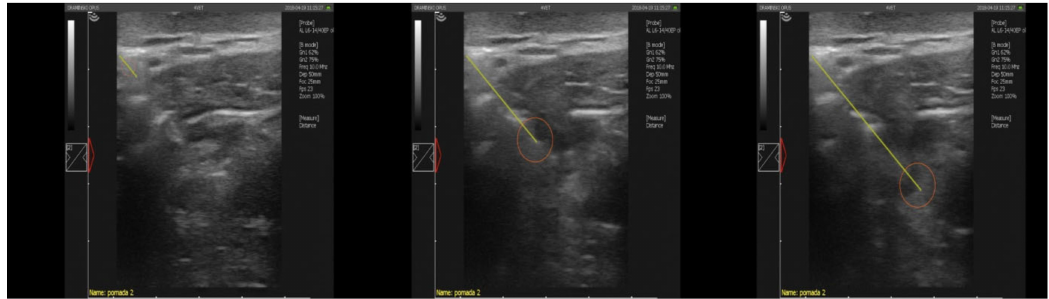
Figure 2. Ultrasound image of the insertion of the biopsy needle into the lateral retropharyngeal node in the European bison (Drami´nski 4VET slim with 60 mm and 7.5 MHz abdominal linear head). Legend: yellow line—the course of the needle puncture, red circle—place of material